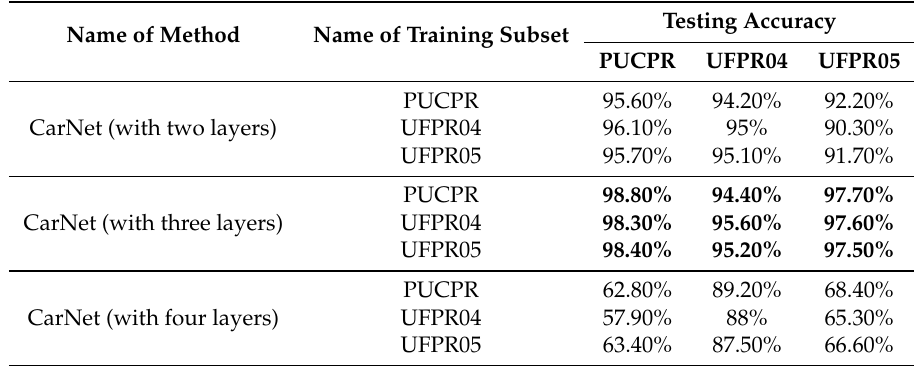
Table 6. Comparison of testing accuracies for Carnet (with two layers), CarNet (with three layers) and CarNet (with four layers).